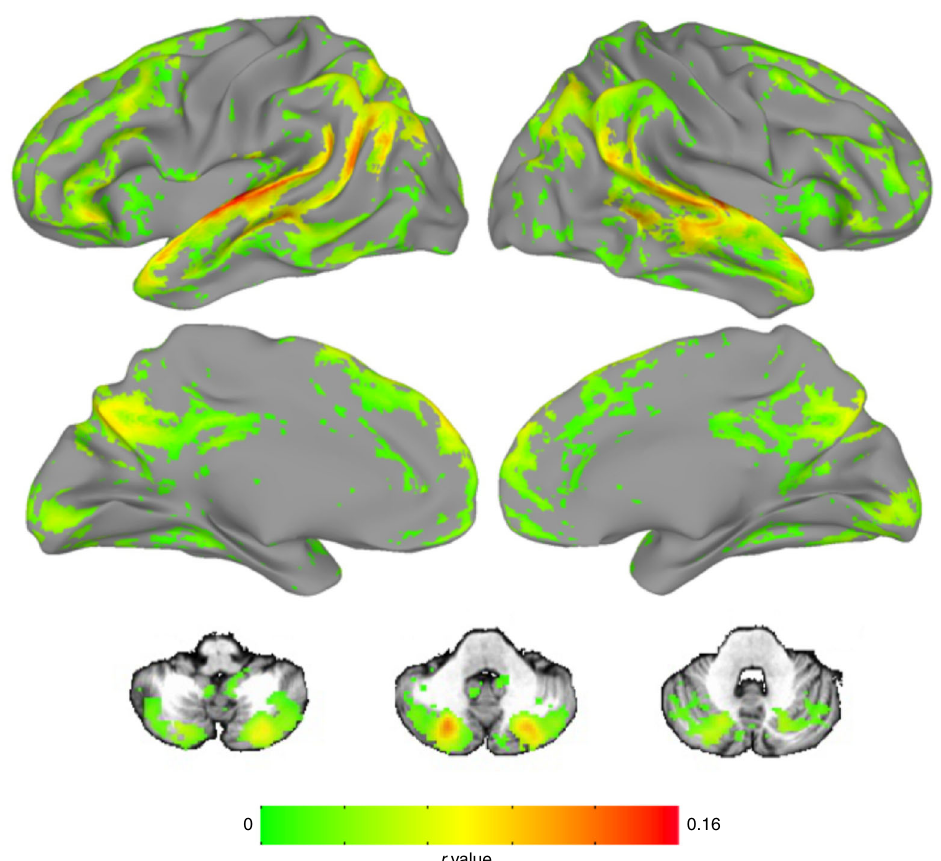
Fig. 2 Narrative listening evokes widespread inter-subject correlation (ISC) across the whole sample. Voxels showing signi fi cant ISC across the time course of narrative listening in all participants ( n = 22). As expected, the highest ISC values were observed in auditory cortex, but several regions of association cortex in the temporal, parietal, frontal, and cingulate lobes as well as the cerebellum also showed high synchrony. Also included are three representative axial slices from the cerebellum ( z coordinates in Talairach space: -38, -35, -29). Results are displayed at a voxelwise false-discovery rate (FDR) threshold of q <